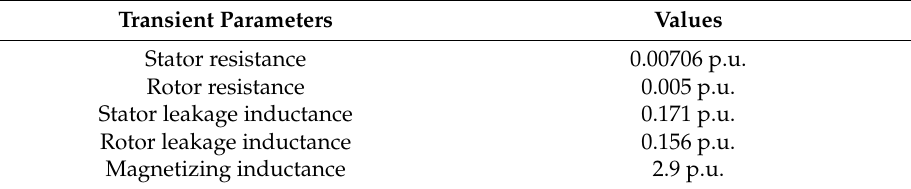
Table A2. Transient relevant parameters of